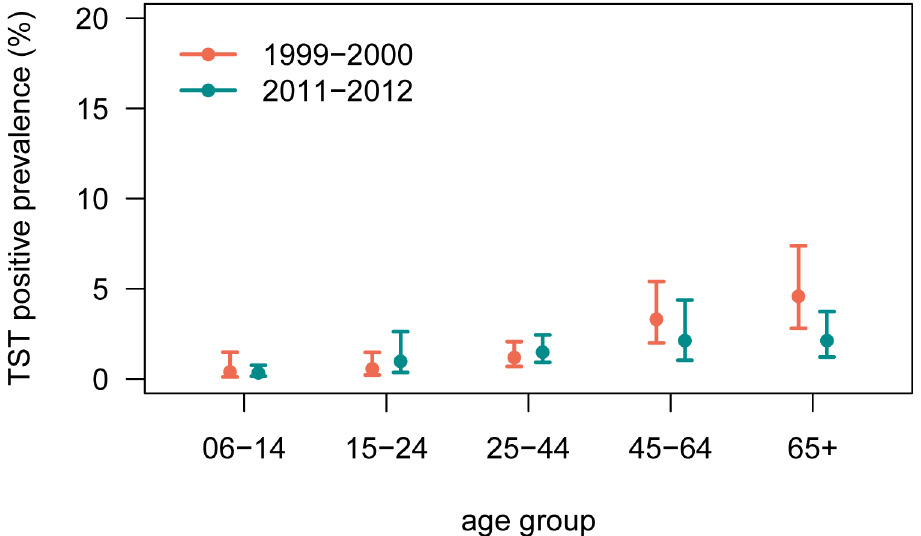
Fig 2. Tuberculin skin test positive prevalence estimates from the civilian, noninstitutionalized U.S.- born population aged 6 years or older, by age group. The orange points represent 1999 – 2000 prevalence estimates and the teal points represent 2011 – 2012 estimates. The vertical lines represent 95% confidence intervals.